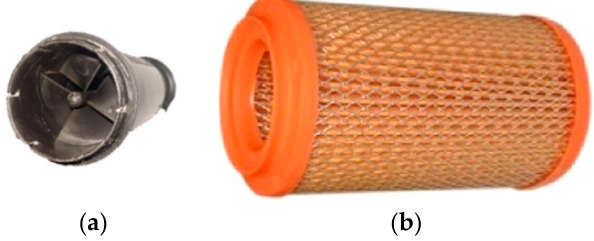
Figure 8. “Filter set” elements: ( a ) through cyclone, ( b ) cellulose cartridge. Table 2. Cellulose filter medium parameters.